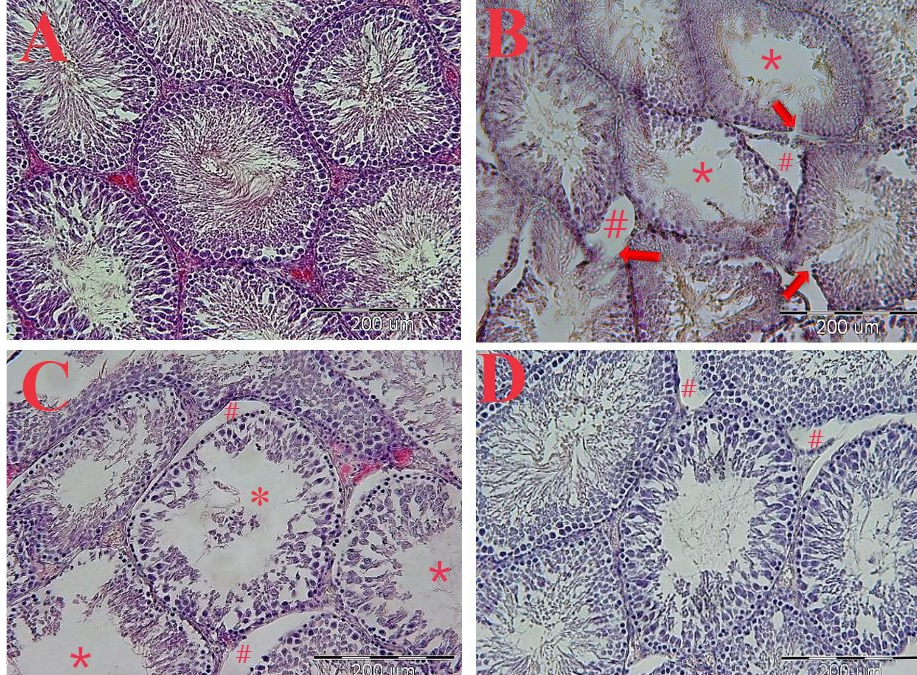
Figure 7. The effects of PO extract on the H&E staining of the transverse section of testicular tissue. ( A ) Control, ( B ) diabetic, ( C ) PO extract (100 mg/kg), and ( D ) PO extract (300 mg/kg). Microscopic view with magnification (20 × ) of the cross-section of testicular tissue. ( A ) Sham group: spermatogenic tubes with normal structural and cellular order. ( B ) Control group: geometric deformation of tubules, disintegration and rupture of the epithelium of spermatogenic tubules (arrows), reduction of spermatozoid population (*), increase in the distance between tubules, and atrophy and destruction of interstitial cells (Leydig) (#). ( C ) Treatment group with a dose of 100 mg/kg: The decrease in the density of spermatogenic cells is obvious, and there is a decrease in the number of sperm cells (*) and an increase in the distance between tubules (#). ( D ) treatment group with a dose of 300 mg/kg: a slight increase in the distance between tubules.